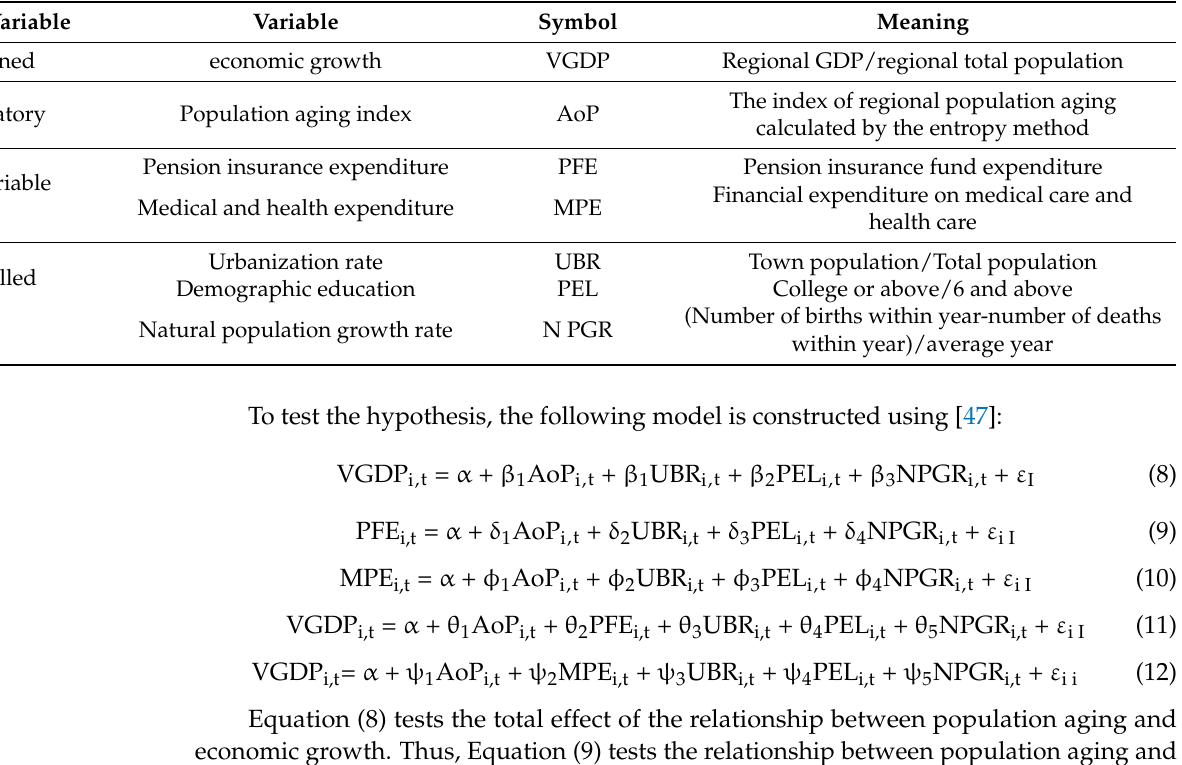
Table 2. Variables and definitions.